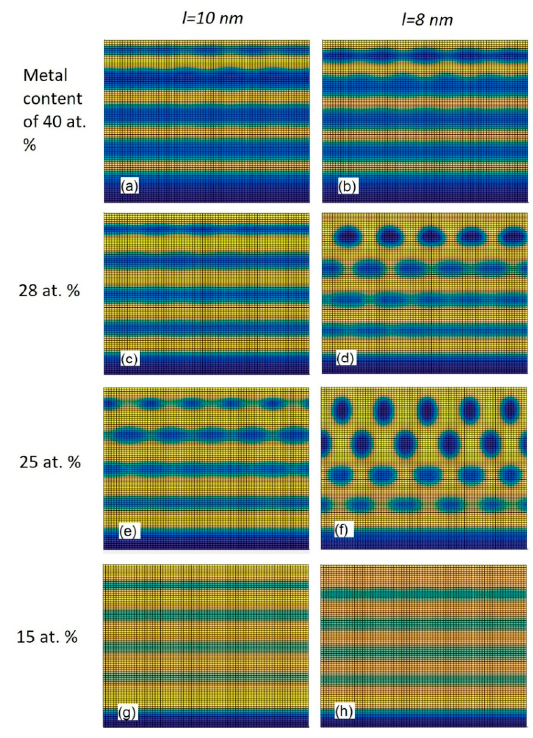
Figure 5. Snapshots obtained by using the modified model with different Ni contents and values of parameter l.